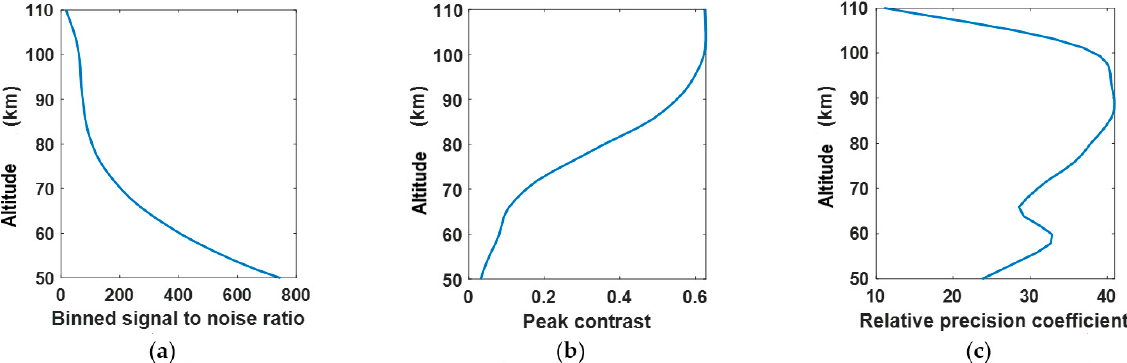
Figure 10. The results of the quantitative evaluation index profiles with altitude. ( a ) The SNR profile. ( b ) The fringe peak contrast profile. ( c ) The relative precision coefficient profile.